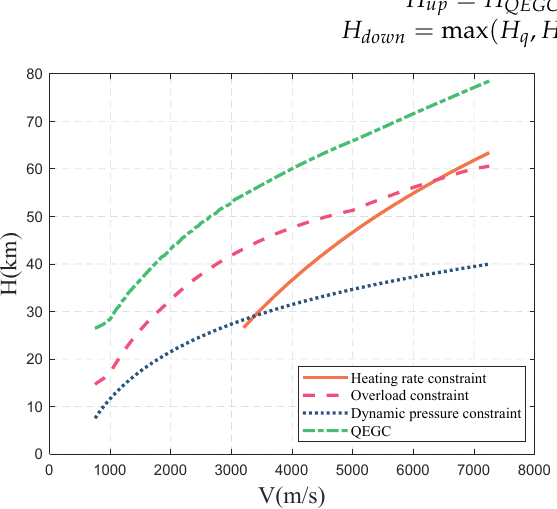
Figure 1. Reentry corridor under constraints.